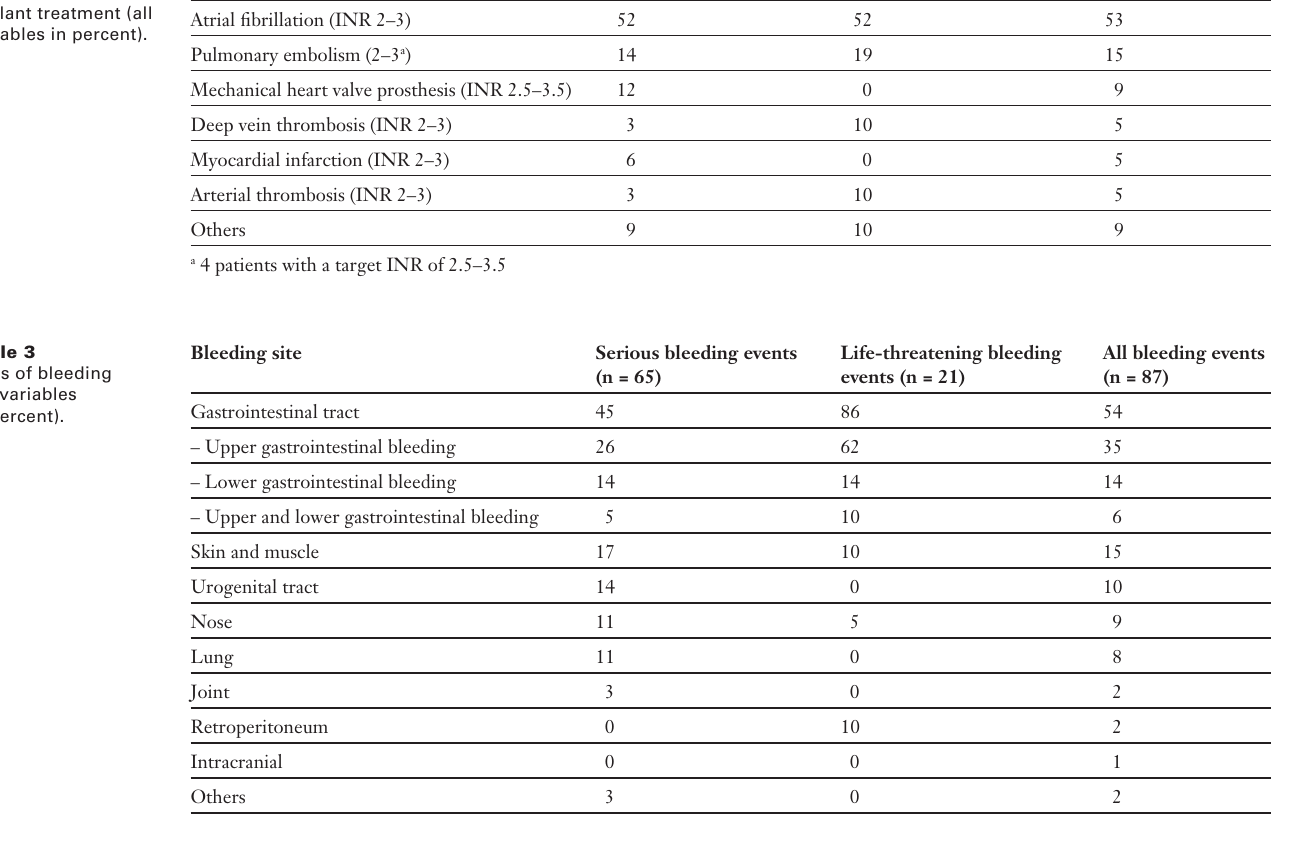
Table 2 Indications for antico- agulant treatment (all variables in percent).